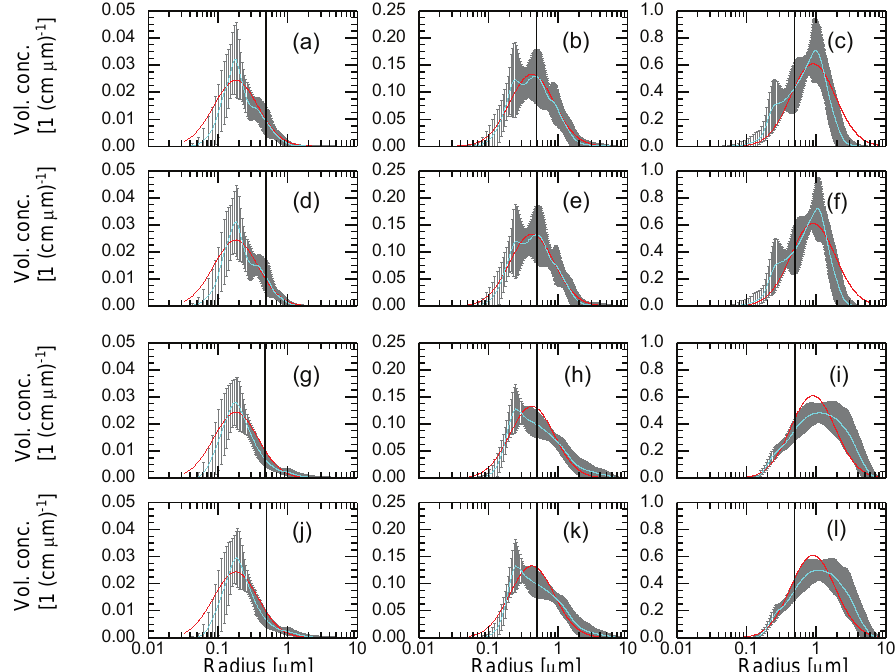
Figure 2. Examples of retrieved particle size distributions for the case of the geometric standard deviation of 2.1, real part of 1.5, imaginary part of 0.01 i and for mean radius of (a, d, g, j) 60nm, (b, e, h, k) 140nm, and (c, f, i, l) 300nm. The true PSD is shown as red curve. The retrieved mean PSDs are shown as solid light blue lines and error bars (grey) in terms of 1 σ standard deviation. The error bars are plotted on a dense grid and follow from the averaging of several hundred individual inversion solutions for each of the mean PSDs. The vertical lines are positioned at 500nm particle radius. We define 500nm particle radius as separation between fine-mode and coarse-mode particles. Row (a–c) represents the results from using the constraint that the real part is known to 0.1 in the data inversion and that the optical data are error free. Row (d–f) shows the results for error-free data and that the real part is known to 0.05. Row (g–i) shows the results if the real part is known to 0.1 and that the optical data have an extreme error of 15%. Row (j–l) shows the results if the real part is known to 0.05 and that the optical data have an extreme error of